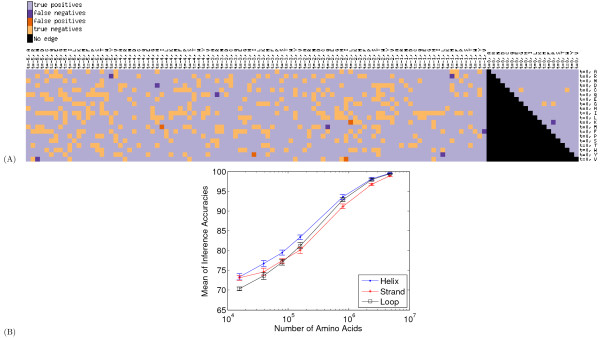
Comparison of learned dlink structure and true dlink structure. (A) This is a discretized version of Figure 2(A). For a given pair of matrices, we can characterize each edge as a true positive if it occurs in both the true and inferred dlink matrix, a true negative if it occurs in neither, or a false positive or false negative if it occurs only in the inferred or only in the true matrix, respectively. In the resulting sparse model, an edge (i.e., dlink) is counted as occurring when the absolute value of its dlink coefficient is greater than zero. Otherwise, it is counted as non-occurring. In the figure, each dlink is colored according to whether it is a true positive, false positive, true negative or false negative. Overall, this particular inference procedure yields 4 false positives, and 9 false negatives from a total of 2190 possible edges, for an accuracy of 2177/2190 = 99.4%. (B) The figure plots inference accuracy ((TP + FP)/(TP + FP + TN + FN)) as a function of training set size, for a fixed sparsity level of 20%. As the size of the training set grows, the algorithm is able to converge to the true sparse model.